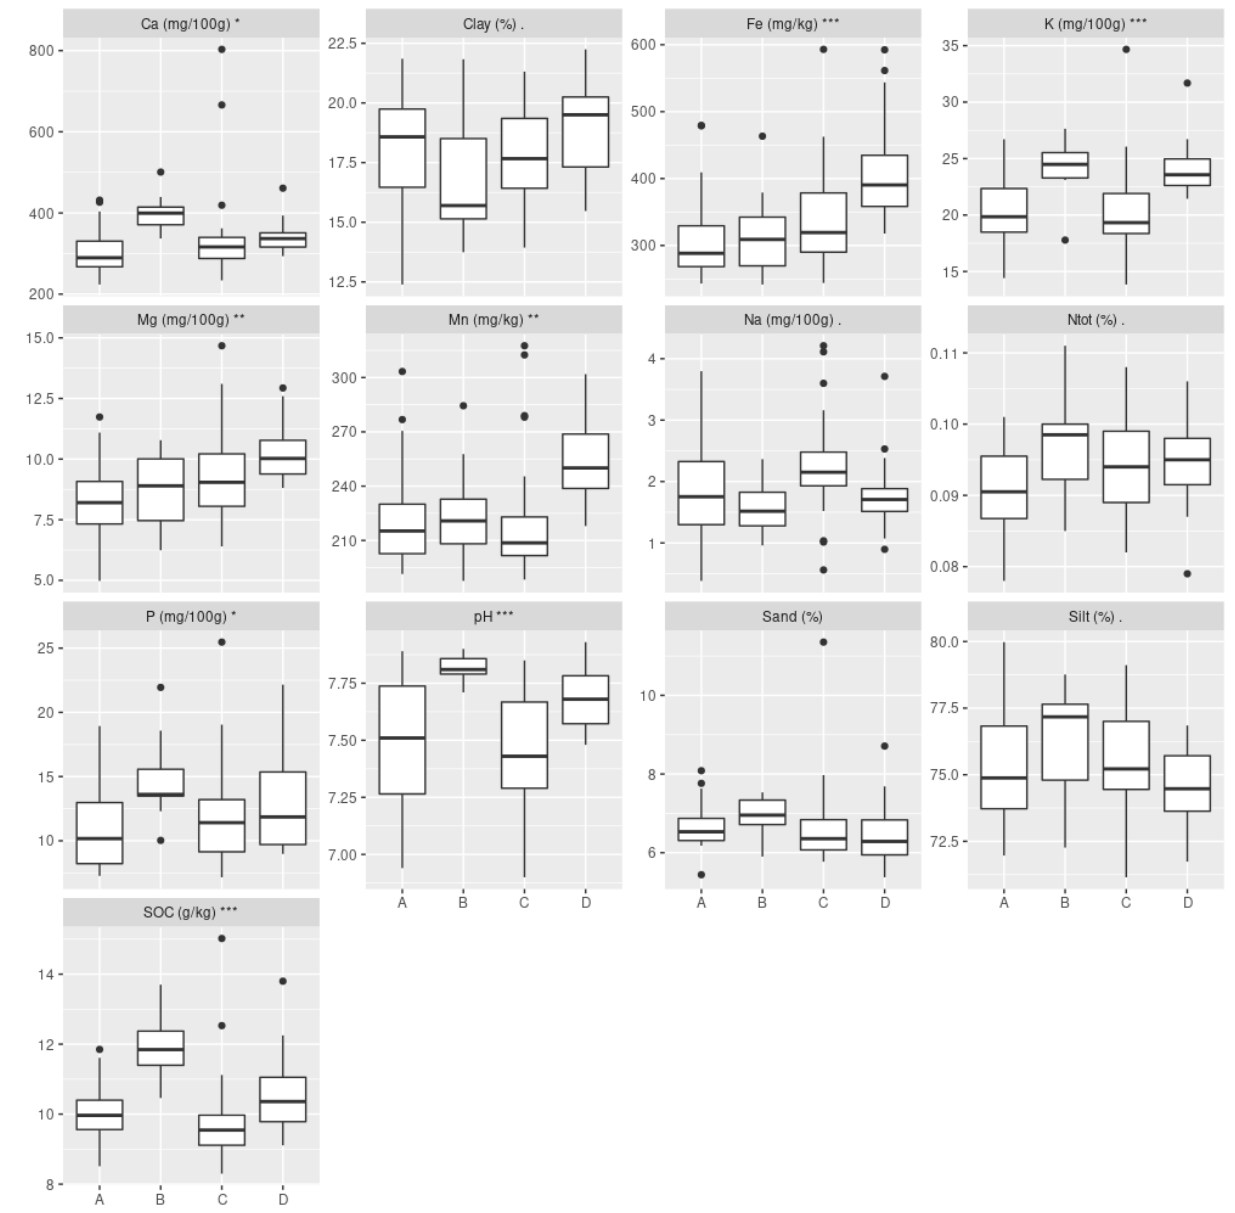
Figure A2. Boxplots of the soil parameters (samples) for the four previous parcels (A, B, C, and D) of the former field layout (see Figure 1). The p -value significance code resulting from ANOVA test for each variable and between the four previous fields is indicated after the variable name. Significance code : *** = 0 to 0.001 p -value; ** = 0.001 to 0.01; * = 0.01 to 0.05 ; . = 0.05 to 0.1.